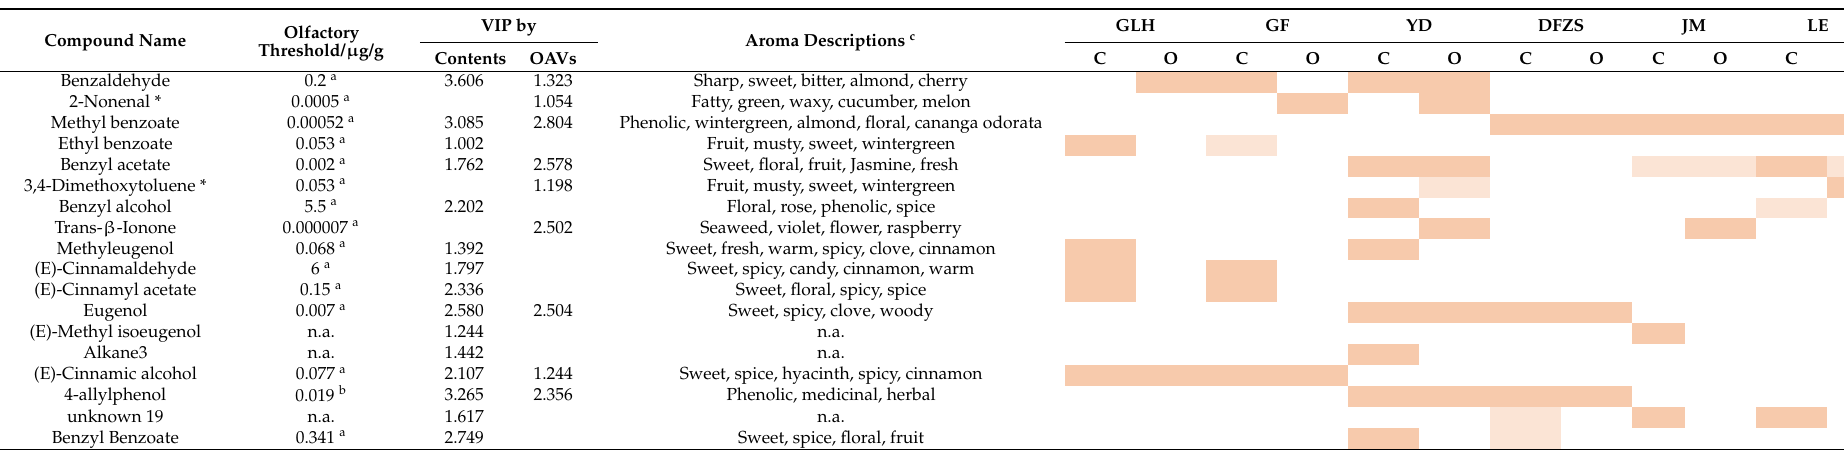
Table 4. Comparisons of the differential compounds screened by the contents of 89 detected and OAVs of 65 identified compounds in different